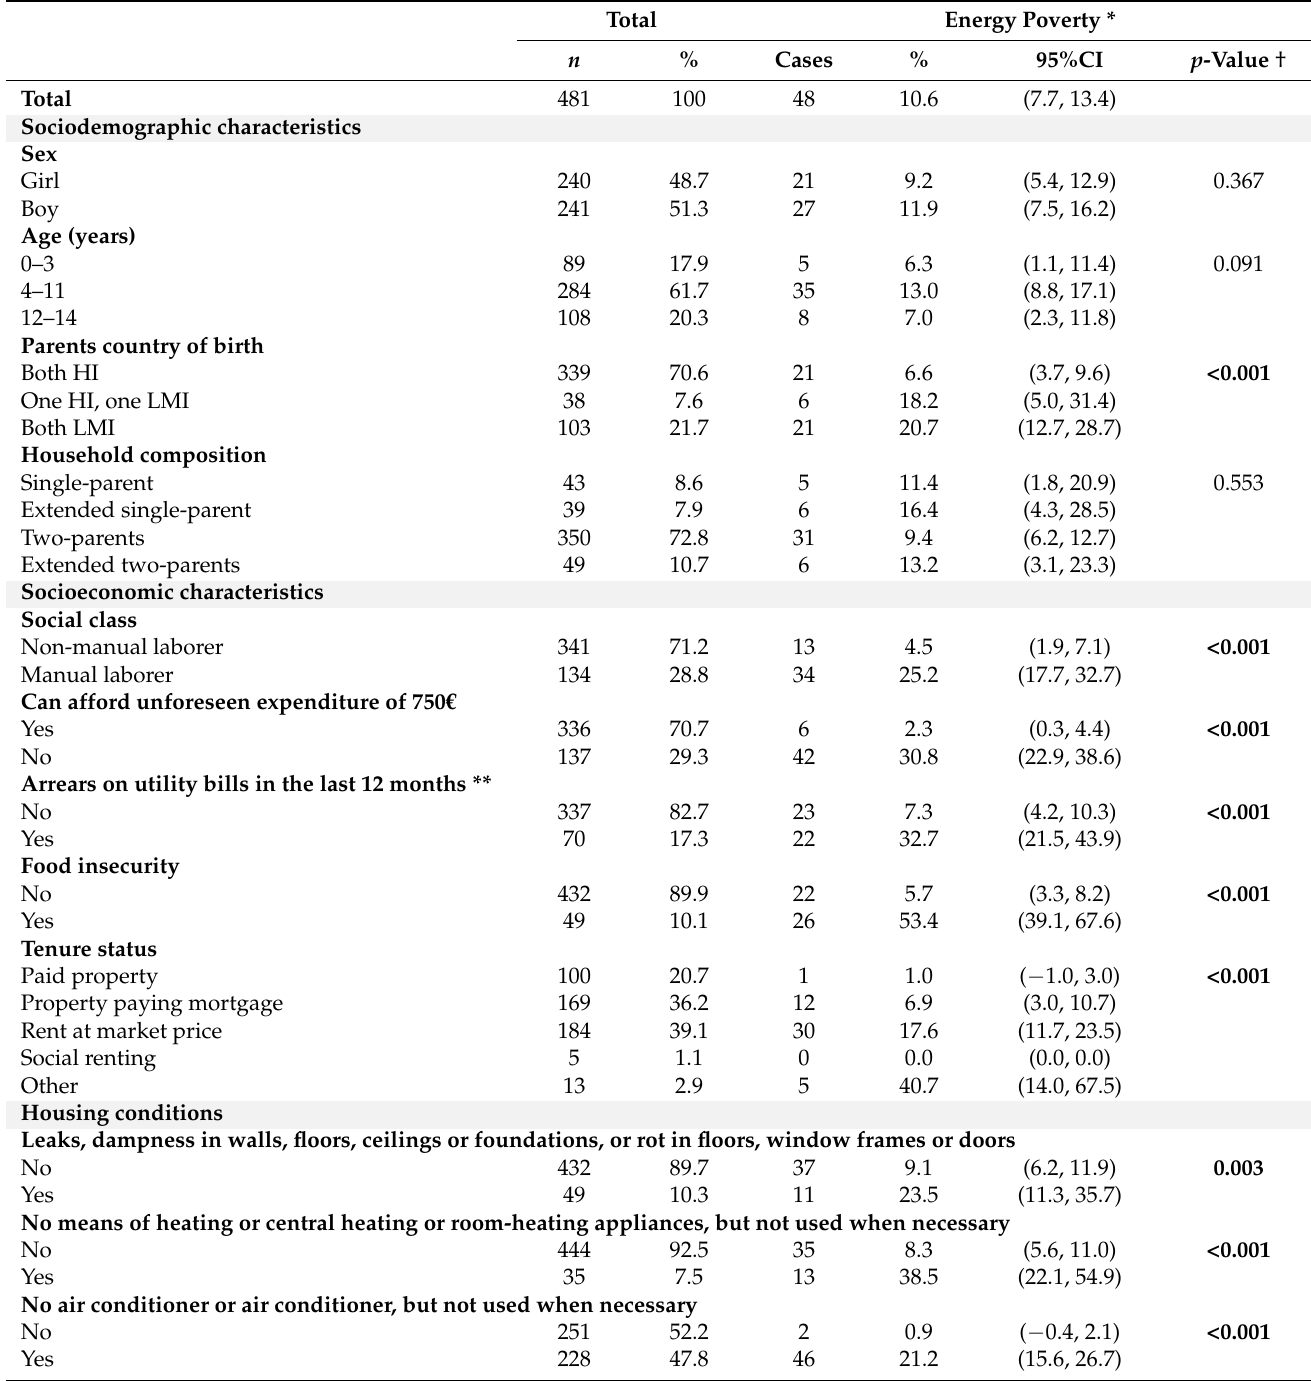
Table 1. Description of the sample and percentages of energy poverty by sociodemographic and socioeconomic characteris- tics and housing conditions. Barcelona